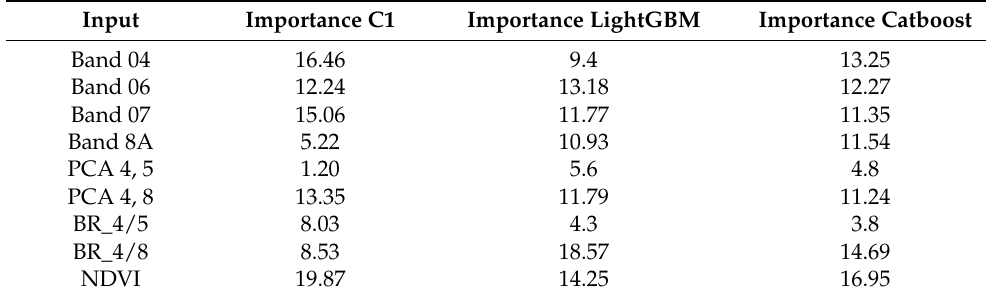
Figure 20. RF classifier. Pegmatites are classified as red colour, granite as beige, water as blue, and vegetation as green. ( a ) Overview of the study area where Håkonhals mine is highlighted by the orange rectangle and Jennyhaugen mine by the blue rectangle. ( b ) Håkonhals mine in focus. ( c ) Jennyhaugen mine in focus. Table 7. Importance of inputs in image classification, measured in percentage.